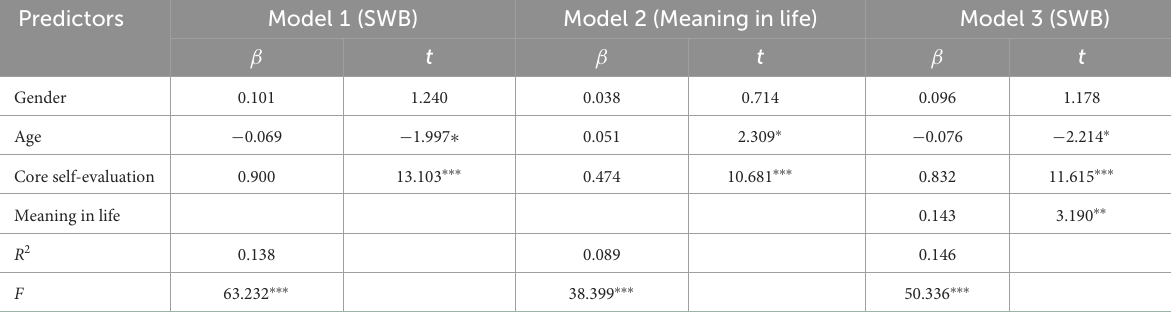
TABLE 2 Testing the mediation effect of meaning in life on SWB.